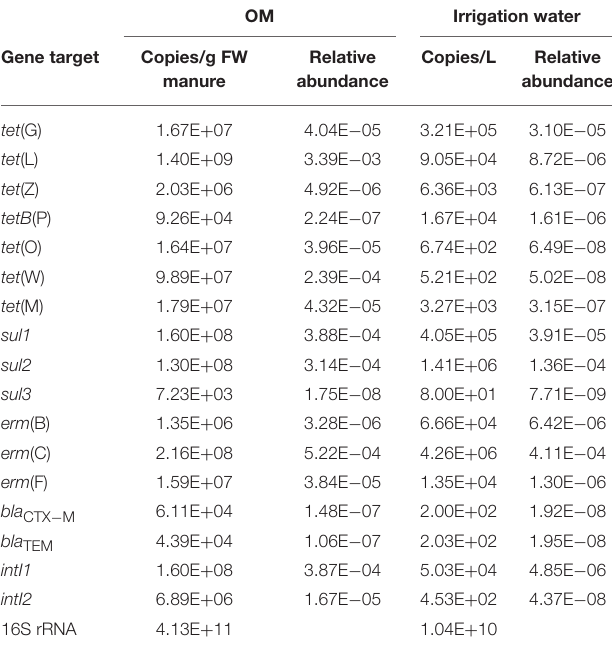
TABLE 1 | Abundance of ARGs and 16S rRNA gene in organic manure (OM) and irrigation water.